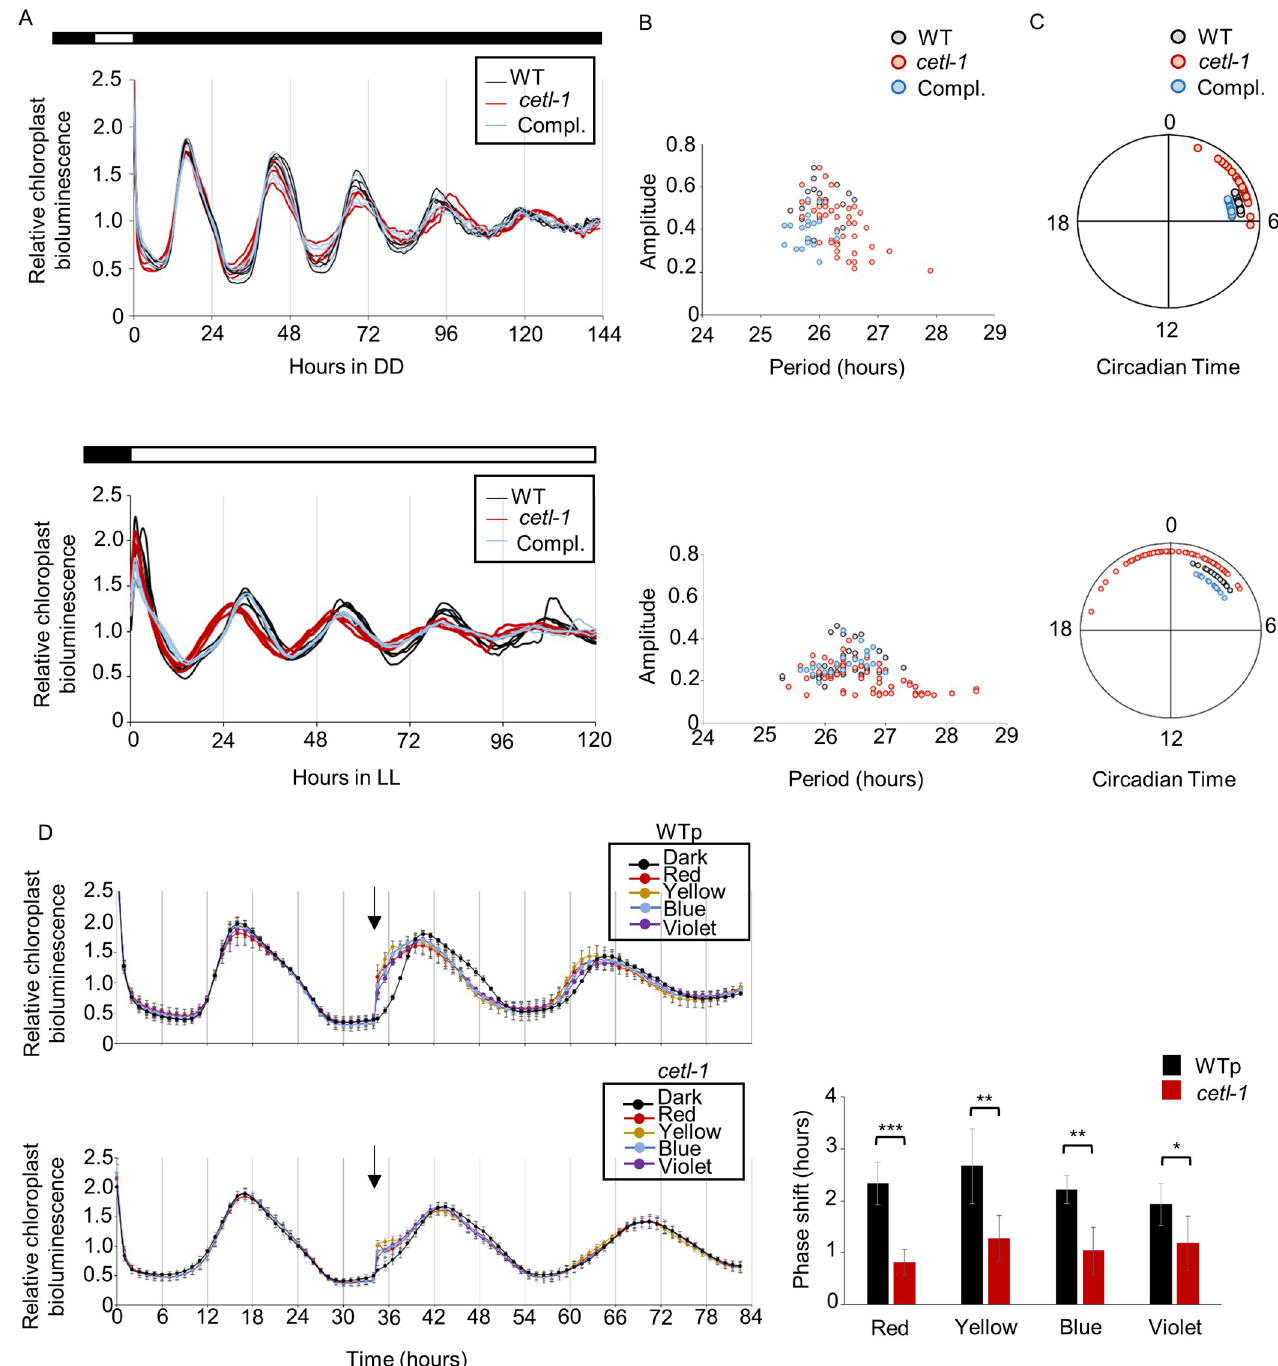
Fig 6. Circadian rhythm under DD and LL conditions and light-induced phase resetting. The mating type - (mt - ) strain of the cetl-1 mutant ( S2 Fig ) and the complement ( S4 Fig ) were crossed with the CBR strain (mt + ) (wild type [WT]) to obtain progenies that inherited the chloroplast luciferase reporter (but not the ROC15-LUC ) along with cetl-1 mutation (1–3), or along with both the cetl-1 mutation and the CETL transgene (Compl.). These progenies were selected by antibiotic screening and genomic PCRs. Spot cultures of these progenies were synchronized by a 12-hour dark/12-hour light or 12-hour darkness before release into DD or LL conditions (2 μ mol m -2 s -1 ), respectively. A. Representative traces of chloroplast bioluminescence rhythm in the cetl-1 mutant under DD (top) and LL (bottom) conditions. Data of 3–5 biological replicates of the WT, a cetl-1 progeny, and a complemented progeny from a single trial are shown. The light regime used is also depicted above the graphs. B and C . The period and amplitude (B) and phase diagram indicating the circadian phases (C) of the rhythms under DD (top) and LL (bottom) conditions. Data points correspond to the results of biological replicates of the WT and three cetl-1 progenies across four